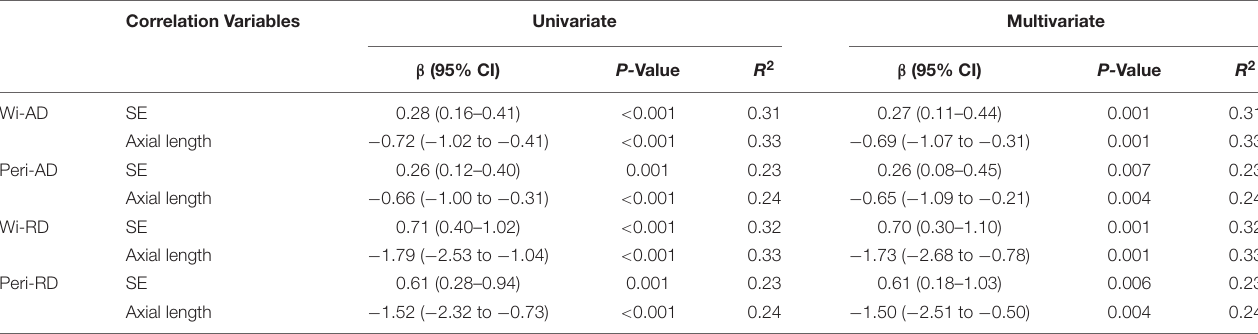
TABLE 5 | Linear relationships between retinal vasoreactivity and spherical equivalent and axial length in POAG. Correlation